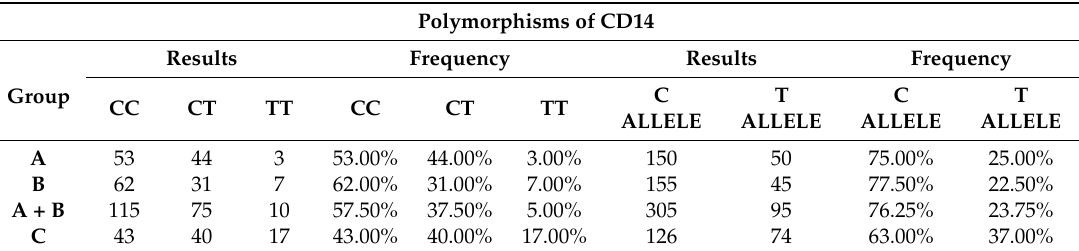
Table 4. Frequencies of CD14/C-260 T polymorphism.